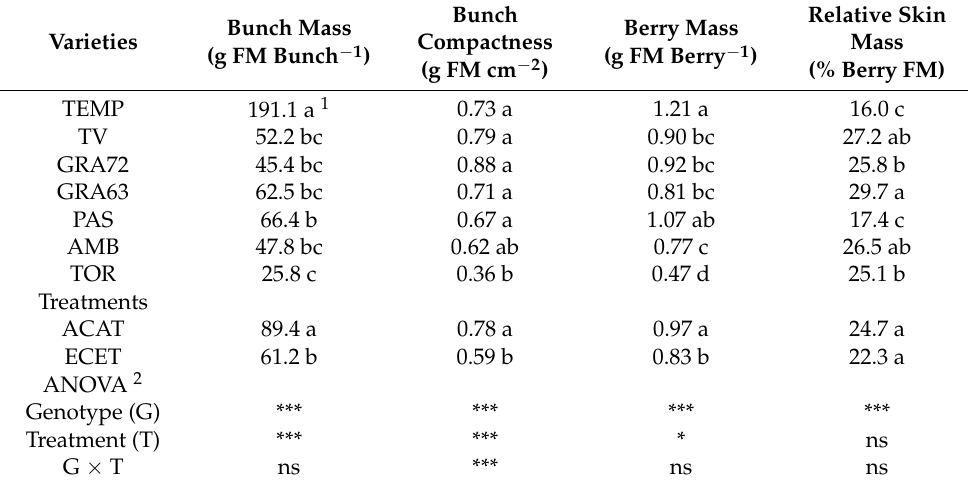
Table 2. Bunch and berry characteristics from fruit-bearing cuttings of genotypes from seven local old grapevine varieties recovered in Navarre (Spain) grown under two climate scenarios during berry ripening: (1) ambient CO 2 (400 ppm) and ambient temperature (T) (ACAT) and (2) elevated CO 2 (700 ppm) and elevated temperature (T + 4 ◦ C) (ECET). Genotype labels can be found in Table